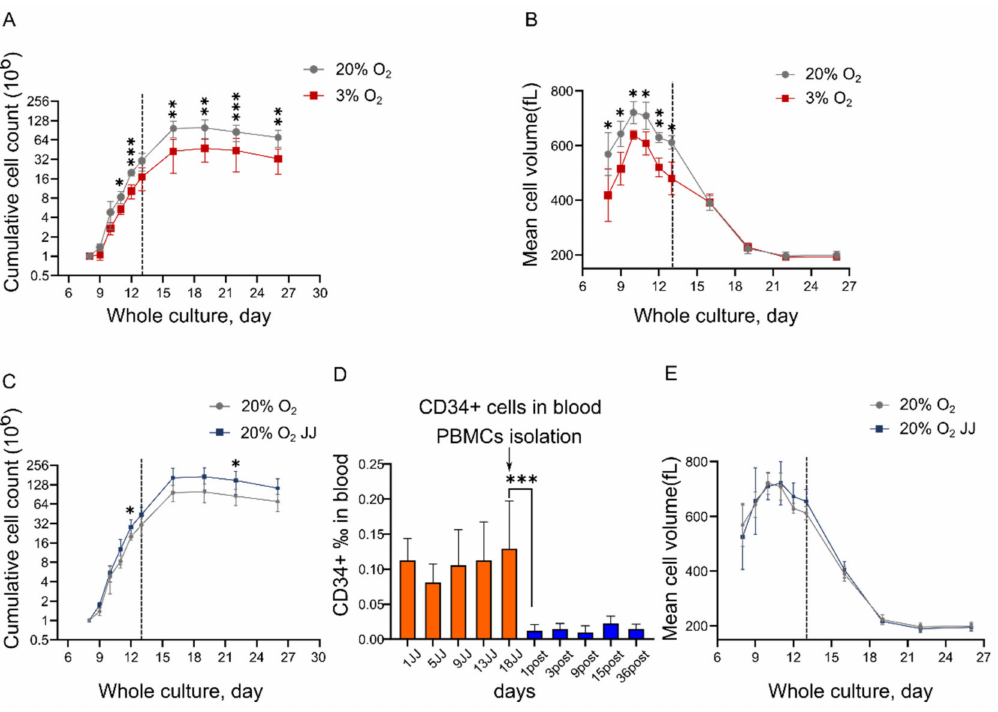
Figure 1. In vitro erythropoiesis performed at 3% O 2 results in a lower erythroid yield and cell volume compared to cultures at 20% O 2 . ( A ) Cumulative growth curve of erythroid cultures from PBMC to enucleated reticulocytes (day 26). Grey dashed line indicates the change from the expansion phase to the differentiation culture condition (day 13 = day 0 differentiation), as outlined in Materials and Methods. ( B ) Mean cell volume throughout erythroid cultures was significantly lower in cells at 3% O 2 during expansion but not during differentiation. ( C ) High altitude (20% O 2 JJ) cultures resulted in an increased erythroid yield compared to pre-altitude (20% O 2 ) samples. ( D ) Analysis of CD34+ cells revealed a higher percentage of HSPC circulating in peripheral blood at high altitude. These measurements were performed on all 12 volunteers involved in the high-altitude study. ( E ) Mean cell volume between 20% O 2 and 20% O 2 JJ samples was comparable. Data on cultures represent results of 5 of the volunteers involved in the high-altitude study (Materials and Methods). Statistical significance was determined using unpaired student t -test, with * = p < 0.05, ** = p < 0.01 and *** = p <